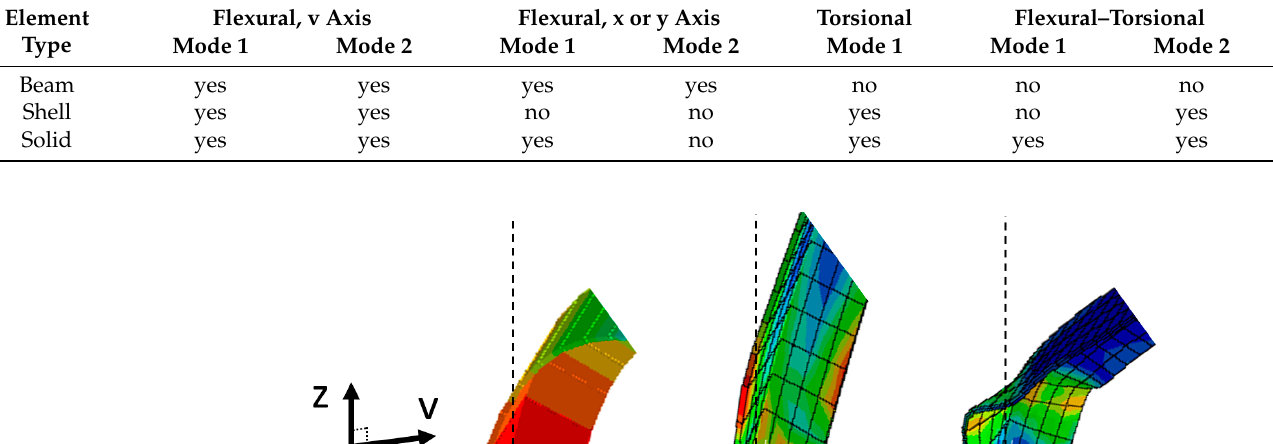
Figure 4. Material characteristic for the different models, alongside the engineering curve from the tensile test.